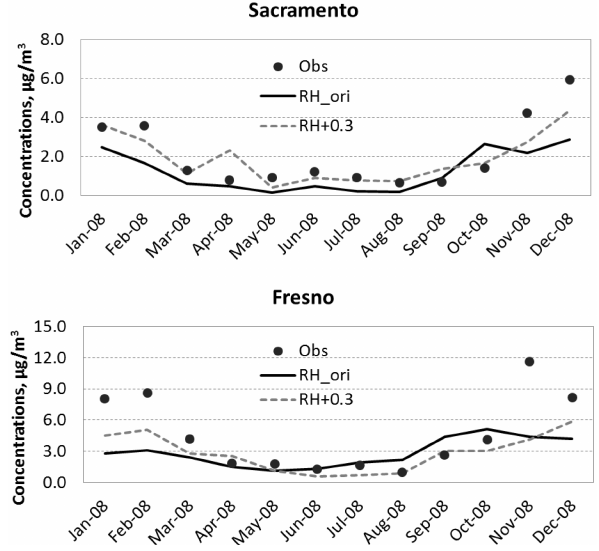
Figure 8. Monthly average nitrate concentrations in 2008 at Sacra- mento and Fresno, predicted with perturbed relative humidity (RH + 0.3), compared to the base-case nitrate predictions (RH_ori) and observed concentrations